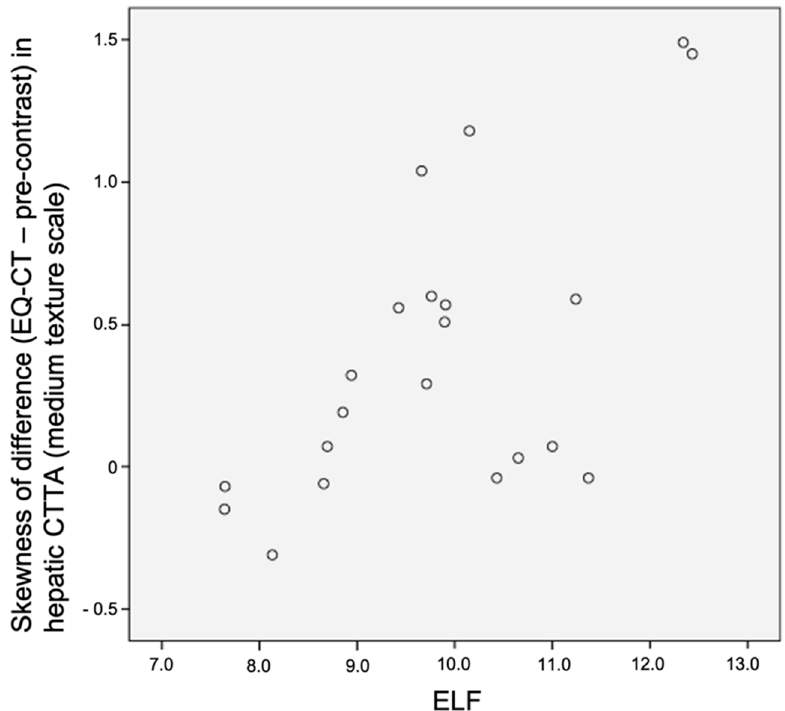
Figure 6. Scatter plot demonstrating correlation between skewness of difference in hepatic CTTA versus ELF in segment VII liver texture analysis (r s = 0.57, p = 0.007). CTTA: CT texture analysis; ELF: enhanced liver fibrosis panel.